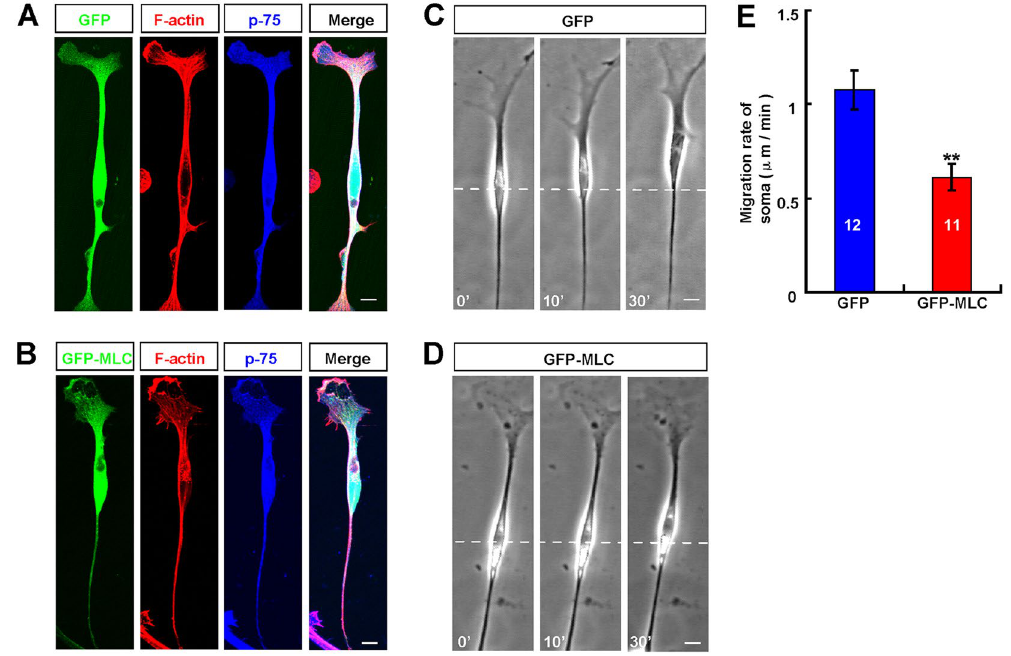
Figure 3. Over-expression of MLC reduced OEC migration. ( A–B ) Double immunostaining of F-actin (red) and p-75 (blue) in OECs transfected with EGFP ( A ) or EGFP-MLC ( B ). ( C–D ) Time-lapse images of migrating OECs transfected with EGFP ( C ) or EGFP-MLC ( D ). ( E ) Quantitative analysis of migration rate of OECs transfected with EGFP or EGFP-MLC. Time, min, scale bar, 20 μ m. Data were mean ± SD. ** P < 0.01 , compared with control, Student’s